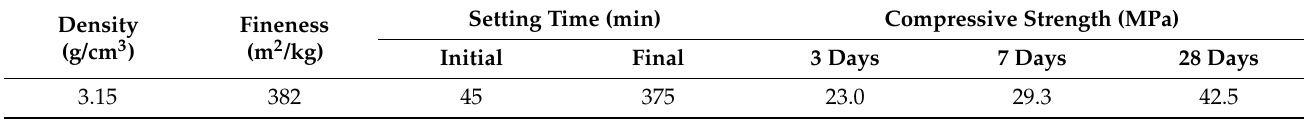
Table 3. Physical properties of